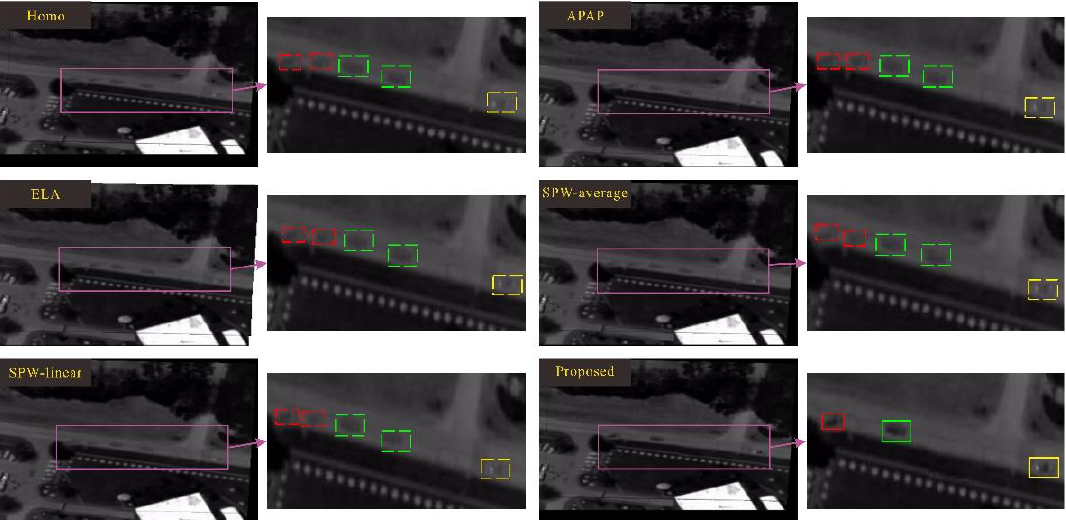
Figure 16. Comparison between the proposed method and SOTA methods on pk02 data.